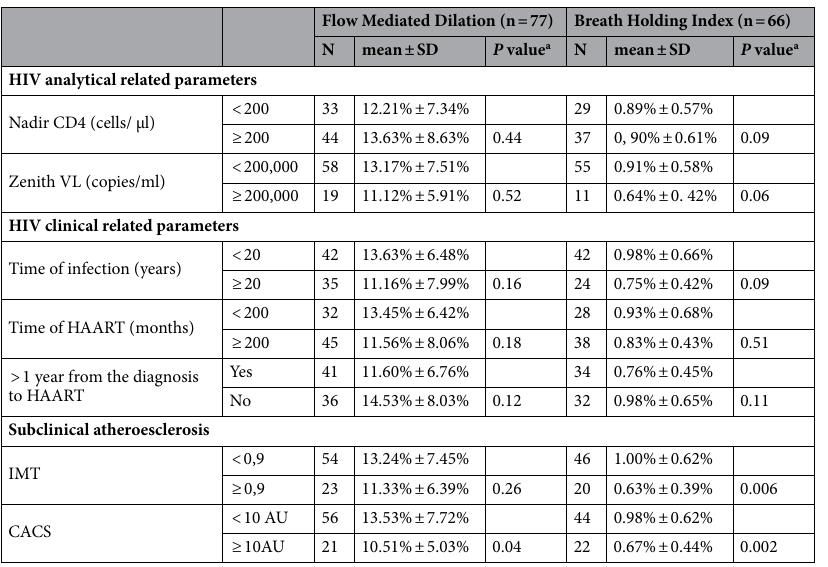
Table 3. Clinical and analytical factors associated with endothelial dysfunction measured by BHI and FMD in patients with HIV infection and the relationship with subclinical atherosclerosis. VL viral load, HAART highly active antiretroviral therapy, IMT intima media thickness, CACS coronary artery calcium score, SD standard deviation, IMT intima media thickness, CACs coronary artery calcium score. a Two-tailed one-way ANOVA test.